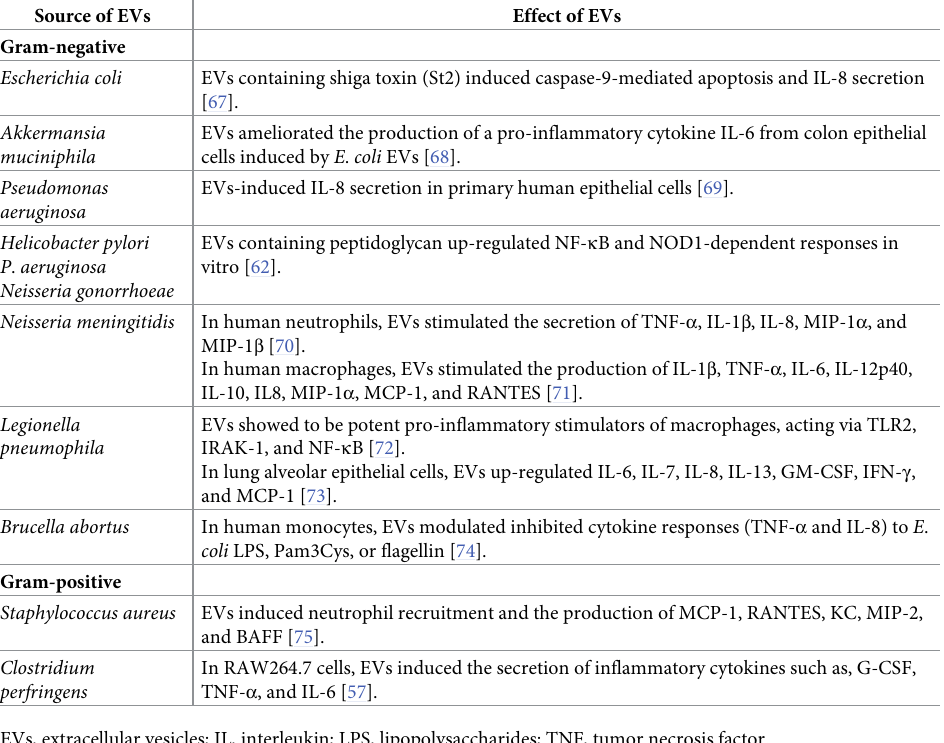
Table 2. Immunomodulatory effect of